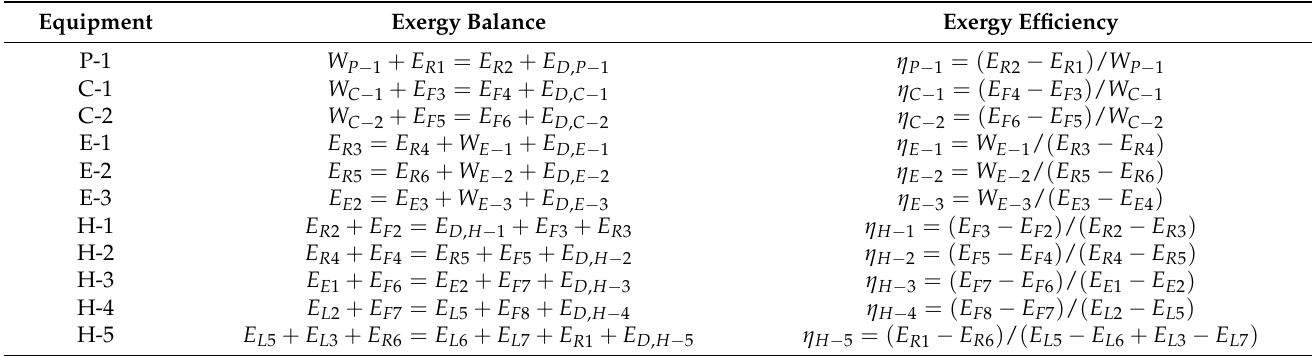
Table 2. The relationship between exergy balance and exergy efficiency of System A key equipment.